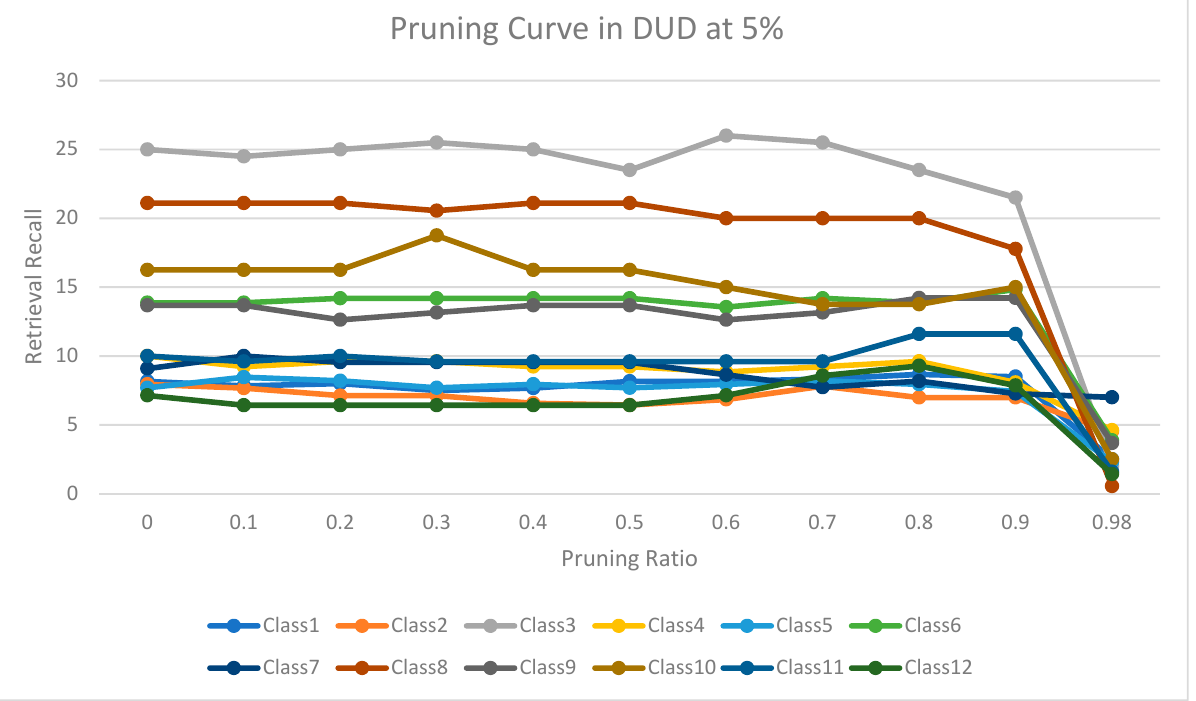
Figure 13. The level of retrieval recall values at different percentages of pruning at the top 5% in DUD dataset.